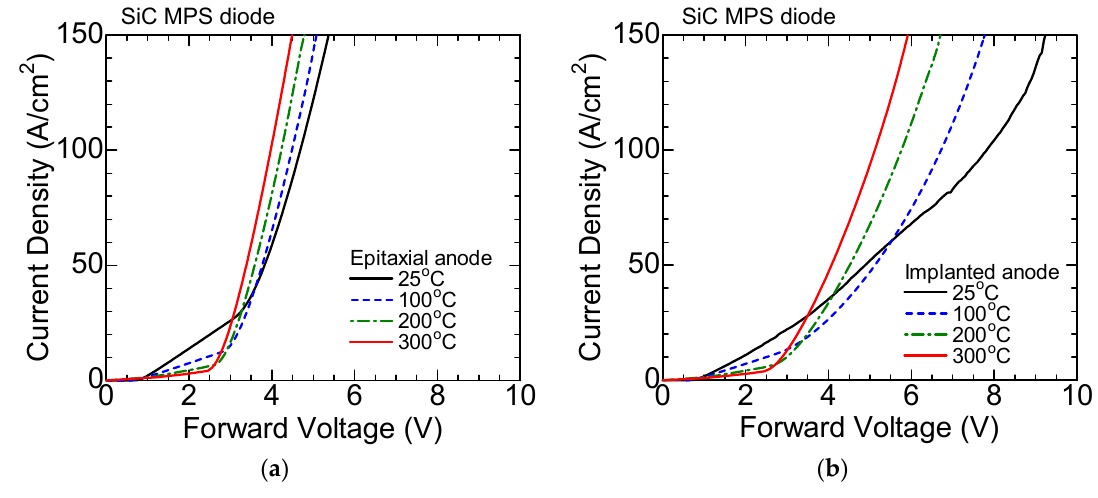
Figure 9. Forward characteristics of ( a ) epitaxial and ( b ) implanted SiC MPS diodes at different temperatures from 25 to 300 °C.